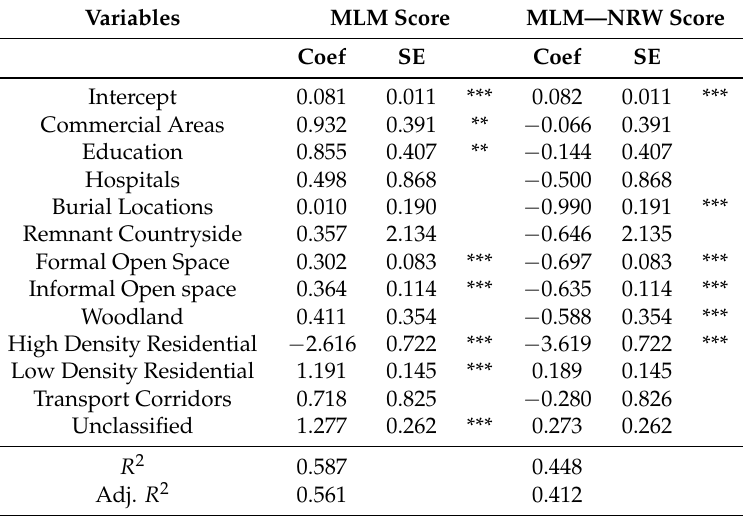
Table 4. Regression